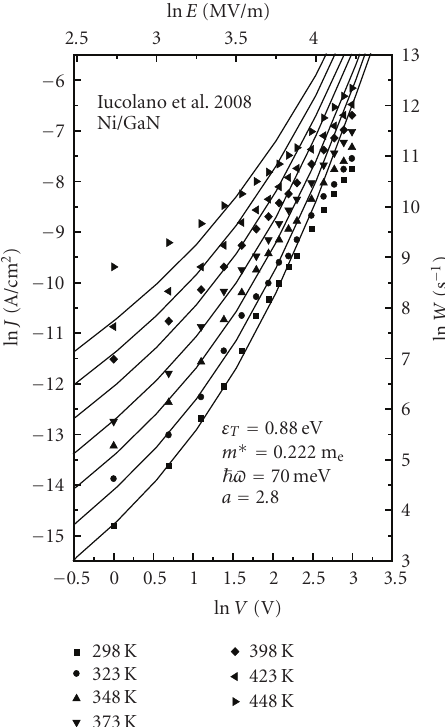
Figure 3: The I-V characteristics of Ni/GaN diode extracted from Figure 6 in [13] (symbols) fitted to the theory (solid curves). Parameters for computation: ε T = 0 . 88 eV, m ∗ = 0.222 m e , (cid:2) (cid:5) = 70meV, a = 2 . 8. Estimated states density N s = 6 . 2 × 10 10 cm − 2